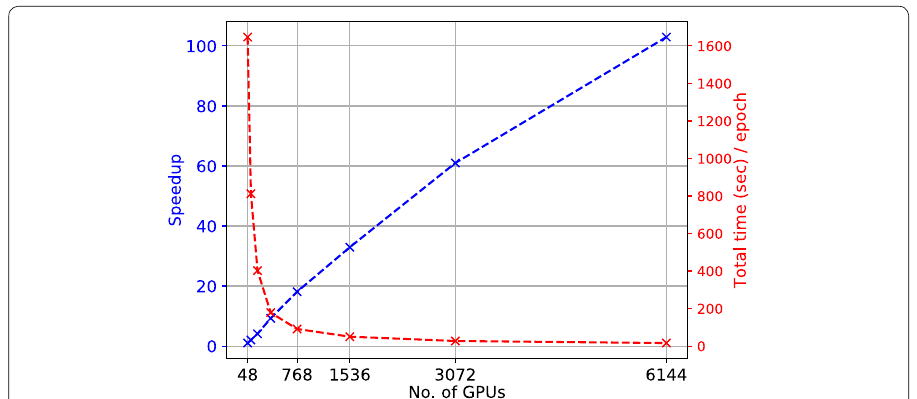
Fig. 5 Gravitational Wave Astrophysics with Summit As Figure 2, but now using 1,536 V100 GPUs in the Summit supercomputer at Oak Ridge National Laboratory. At this scale, the model is trained in 1,2